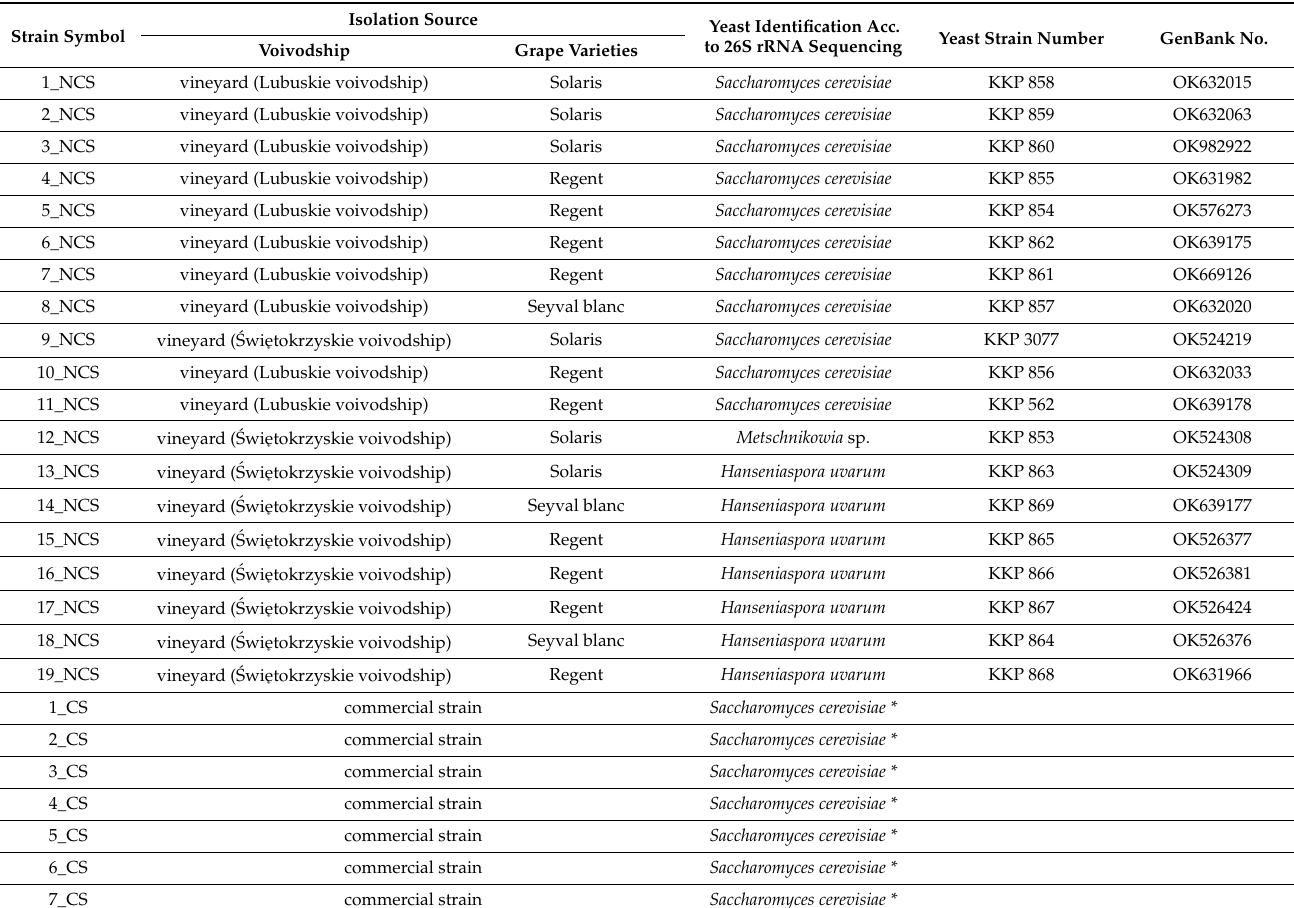
Table 1. The yeast strains used in the preliminary study.